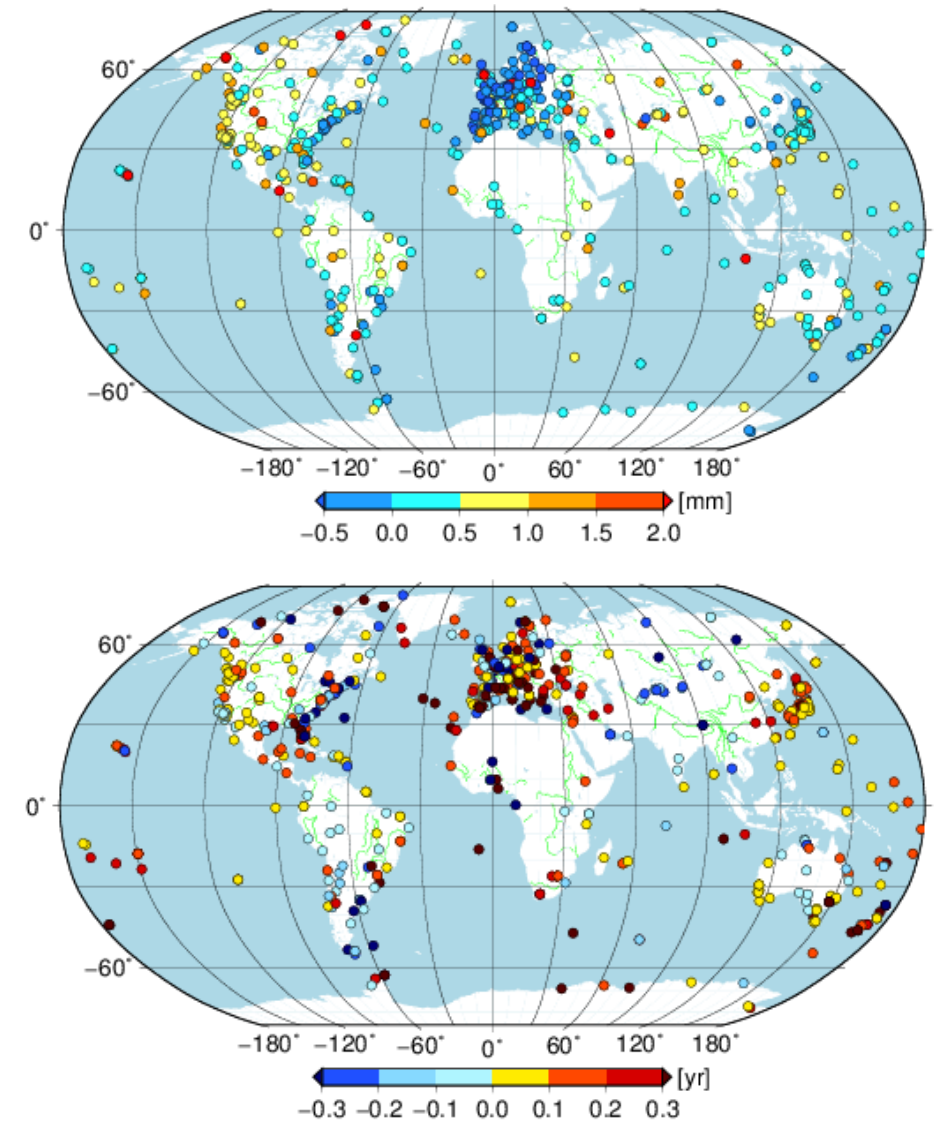
Figure 7. The amplitude ( top panel ) and phase ( bottom panel ) differences of annual signal between GNSS and AOH for east component for the selected 647 global stations.